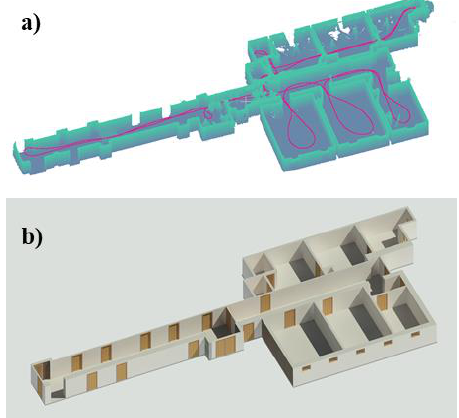
Figure 4: Data set adopted for testing the procedure described in this paper: (a) Point cloud with the IMMS sensor trajectory (red line); (b) BIM model.